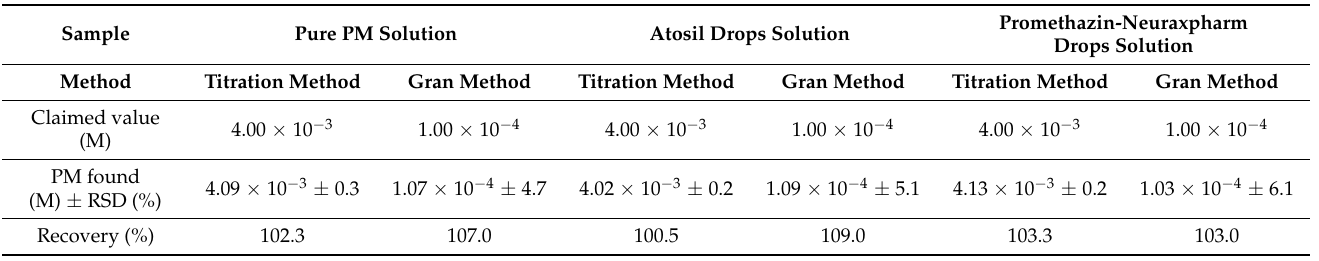
Table 5. Results of the PM determination in pure aqueous solution and pharmaceutical preparations, obtained using potentiometric titration and the Gran method 1